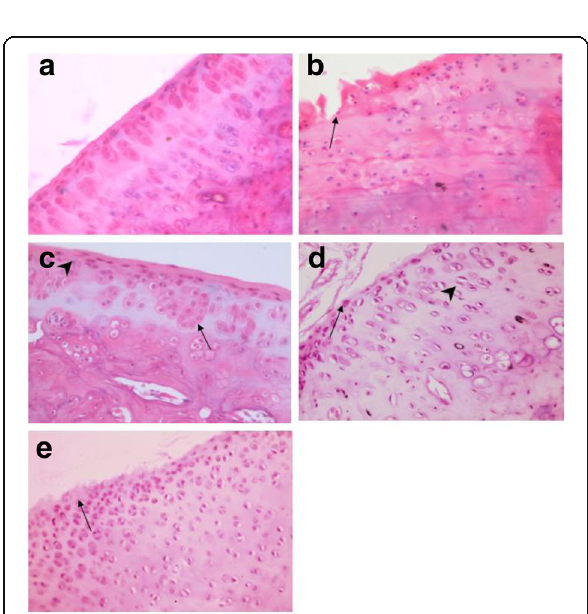
Fig. 6 Photomicrograph of a control group showing normal chondrocytes shape and orientation. b From osteoarthritis group showing denudation, erosion, clefting (arrow) and degeneration of chondrocytes. c F400 group showing superficial fibrillation (arrow head) with more or less normal orientation and some edema (arrow). d From F200 group superficial fibrillation (arrow), proliferation and clustering of chondrocytes, (arrow head) cracking and simple fissures. e From Voltarin treated group showing Loss of superficial layer, chondrocytes necrosis and simple fissures (arrow)